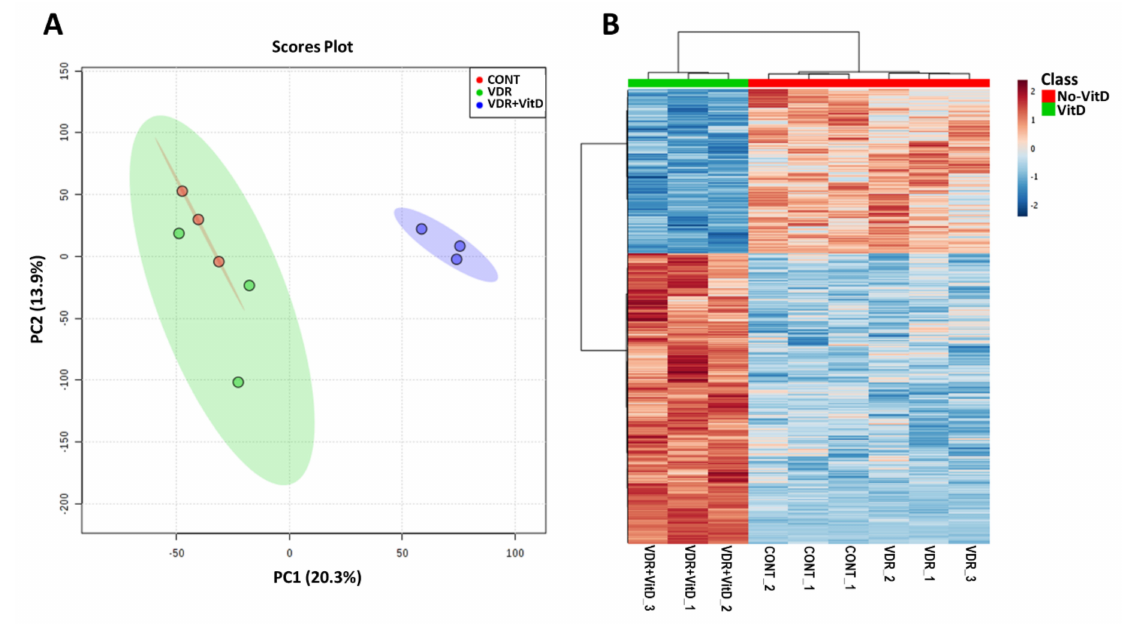
Figure 1. Genome-wide expression profiling of HepG2 cells with activated VDR. HepG2 cells were transfected with Ad-C or Ad-VDR for 48 h. Then, 10 nM Vitamin D (VitD) (VDR + VitD) or vehicle (VDR & CONT) were added for 4h. Total RNA was purified and expression profiling was performed by microarray analysis. Non-informative mRNAs in the dataset were filtered by IQR and 8000 mRNAs were left for further analysis. Mean-centred and SD autoscaling were performed. ( A ) Principal component analysis. ( B ) Hierarchical clustering showing the top 1000 di ff erentially expressed genes.